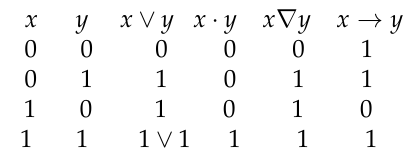
Figure 2. A table of